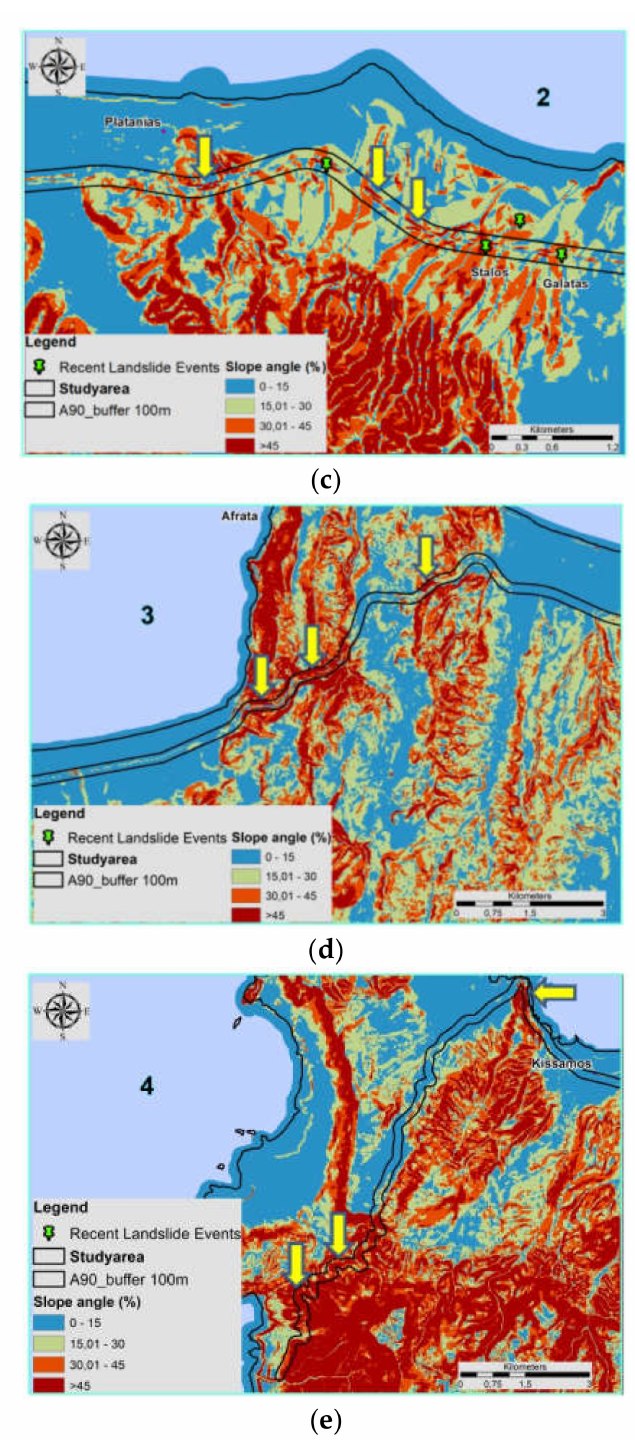
Figure 9. ( a ) Perspective view of the four selected regions distribution, ( b – c ) the selected regions 1-2 where the recent landslide events occurred, ( d – e ) the selected regions 3-4 with very high landslide susceptibility and potential hazard (critical spots indicated with yellow